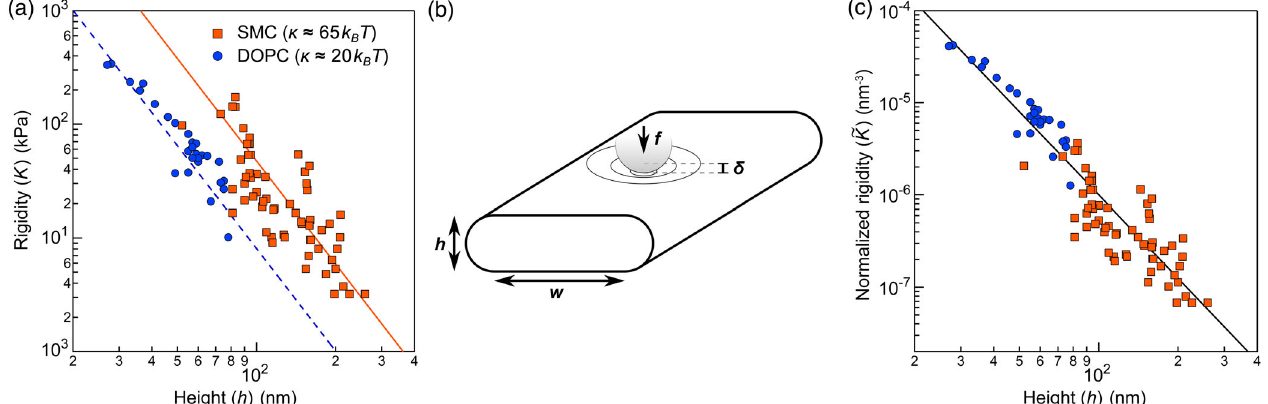
FIG. 5. Nanomechanical properties of membrane nanotubes. (a) Rigidity K plotted against the AFM height h . Each data point represents one nanotube. Lines display the model with no adjustable parameter K ¼ 22 κ 3 = 2 ð k B T Þ − 1 = 2 h − 3 , with κ the bending rigidity of the membrane (see text for details). (b) Schematics of the flattened nanotube and indentation geometry considered in our model. f is the force exerted on the membrane by the AFM tip, δ the indentation depth, h and w the nanotube height and width, respectively. ˜ K (c) Normalized rigidity ¼ K= ½ 22 κ 3 = 2 ð k B T Þ − 1 = 2 (cid:3) versus height for all nanotubes. Data points from the two sets of nanotubes (SMC and DOPC) collapse on the same master curve (black line), as predicted by the model.